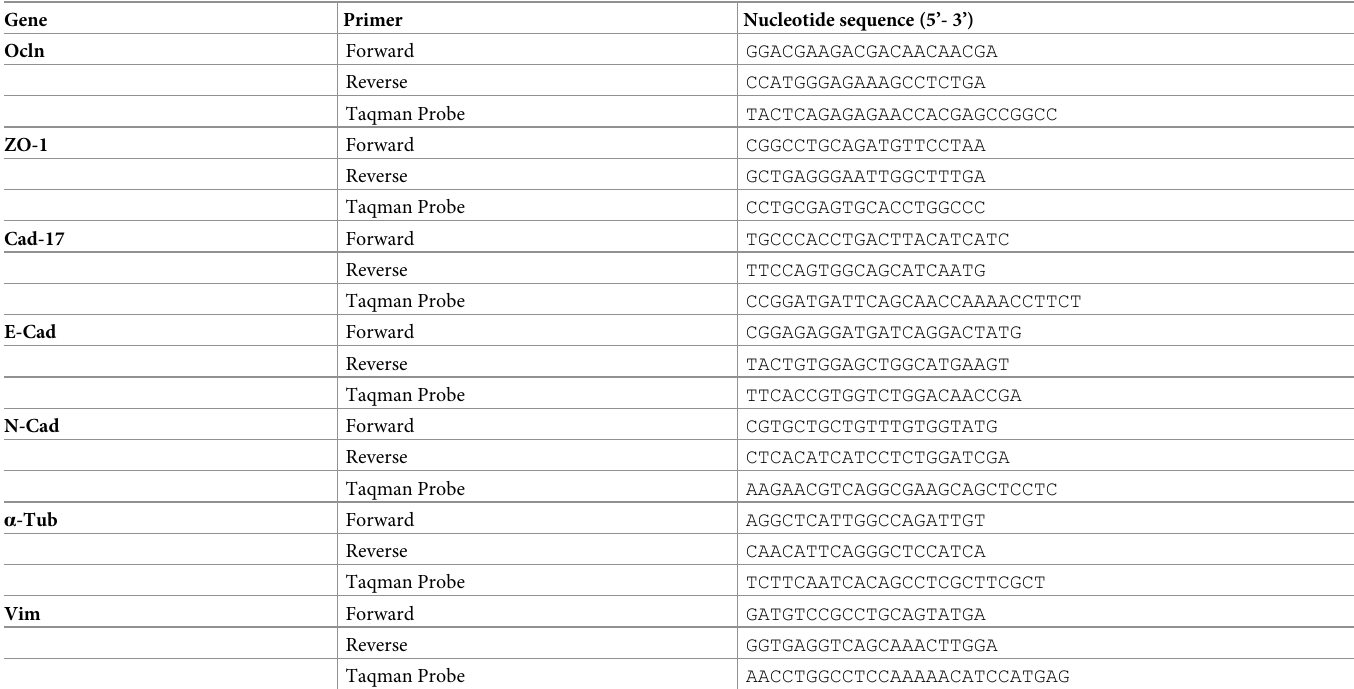
Table 5. Primers and probes used for one-step Taqman real-time RT-PCR.